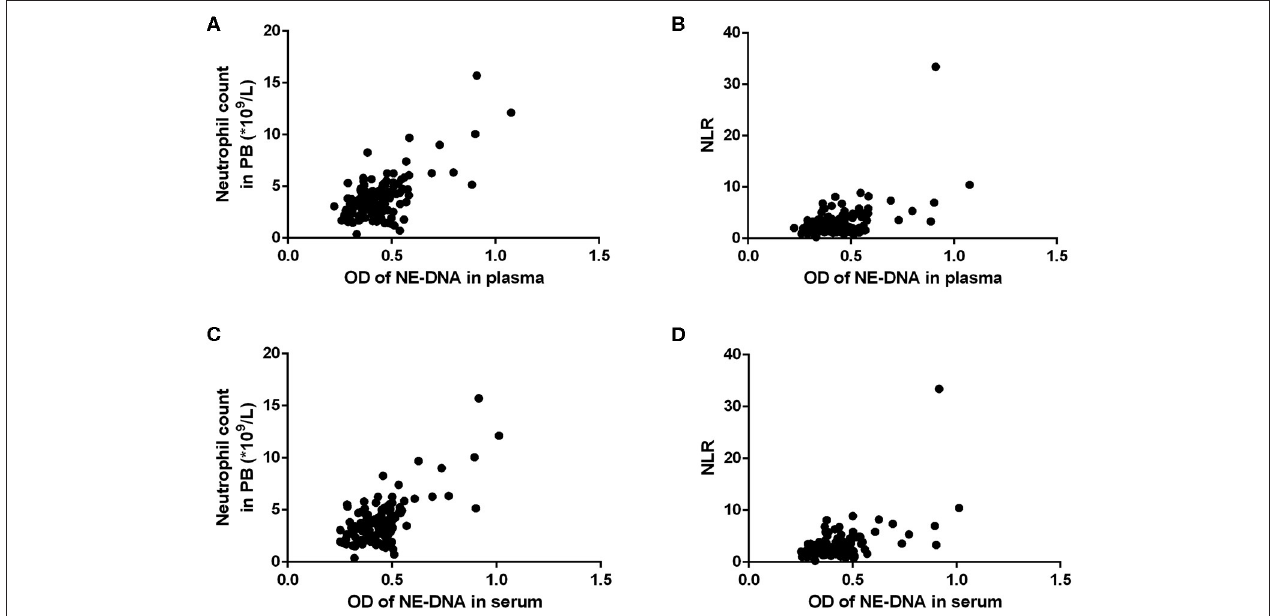
FIGURE 4 | The correlations between the levels of neutrophil extracellular traps (NETs) and the neutrophil count/neutrophil to lymphocyte ratio (NLR) in the peripheral blood (PB) of patients with advanced gastric cancer (GC). (A,B) There were statistically significant correlations between the levels of NETs in the plasma and the